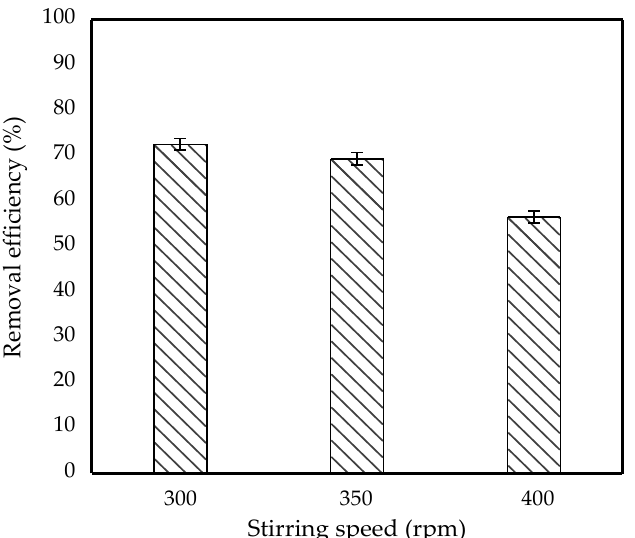
Figure 4. Effect of stirring speed on removal efficiency of 10 ppm IBP. (Conditions: [TOA] = 6 wt%; [Span 80] = 6 wt%; Emulsification time = 15 min; O/I = 3:1, Kerosene = 30